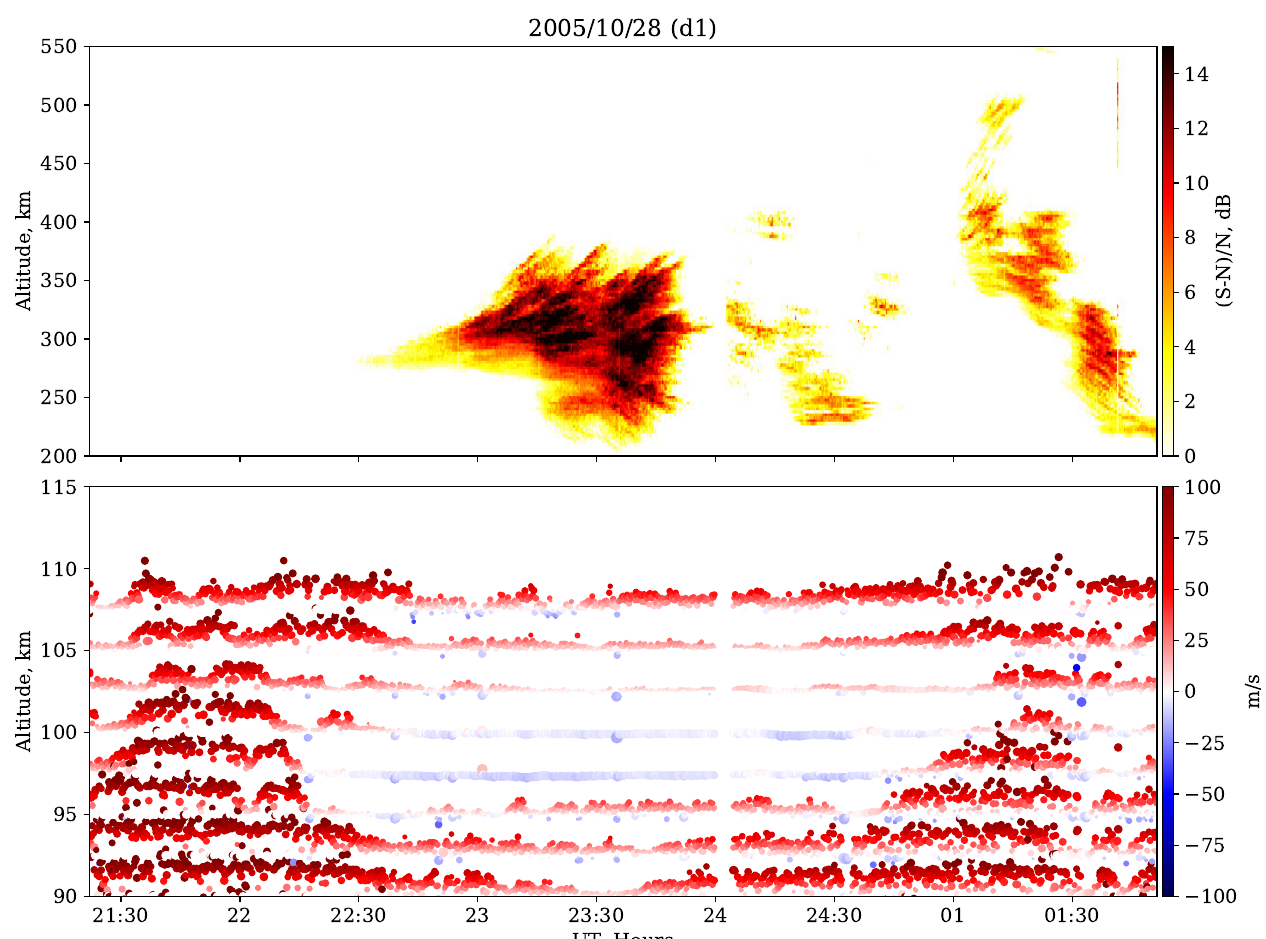
Figure 1. Upper-panel presents Range-Time-Intensity (RTI) Plot of FAI-F region and Lower-Panel presents Range-Time- velocity (RTV) plot of FAI-E on 28 October 2005. Circle size is proportional to the signal-to-noise ratio and the altitude modulation is proportional to the Doppler velocity